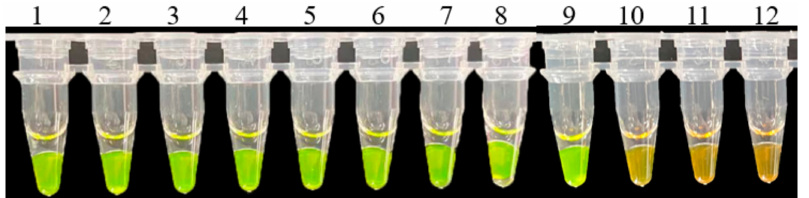
Figure 11. Loop-mediated isothermal amplification (LAMP) detection of P. graminea -infected seeds sampled from fields. Tube 1: DNA from P . graminea (positive control); tubes 2–9: DNA template from infected barely seeds after incubation at 22 ◦ C for 3 days; tube 10: DNA from infected barley seed without incubation; tube 11: DNA from healthy barley seed (negative control); tube 12: ddH 2 O (negative